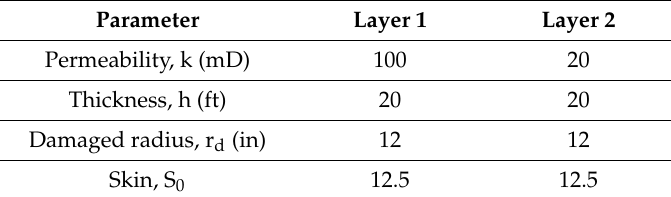
Table 2. Input data for liquid